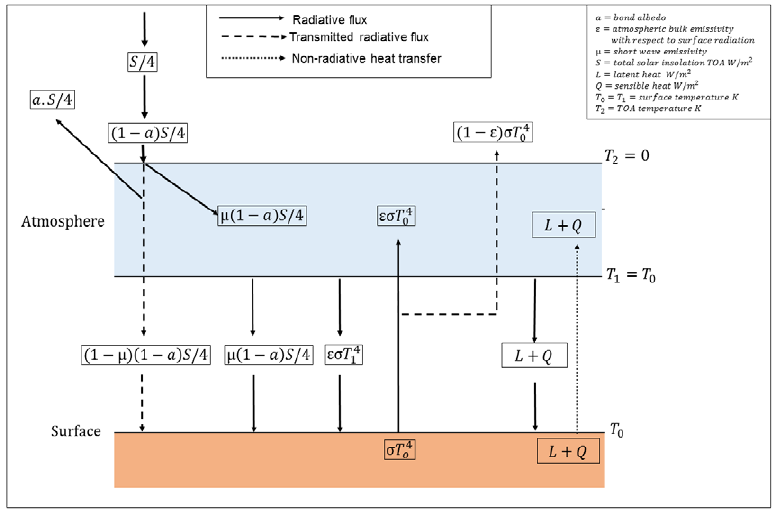
Figure 2. Equilibrium adiabatic radiative model. All of the units are in W/m 2 except temperatures T 0 , T 1 , T 2 , which are in